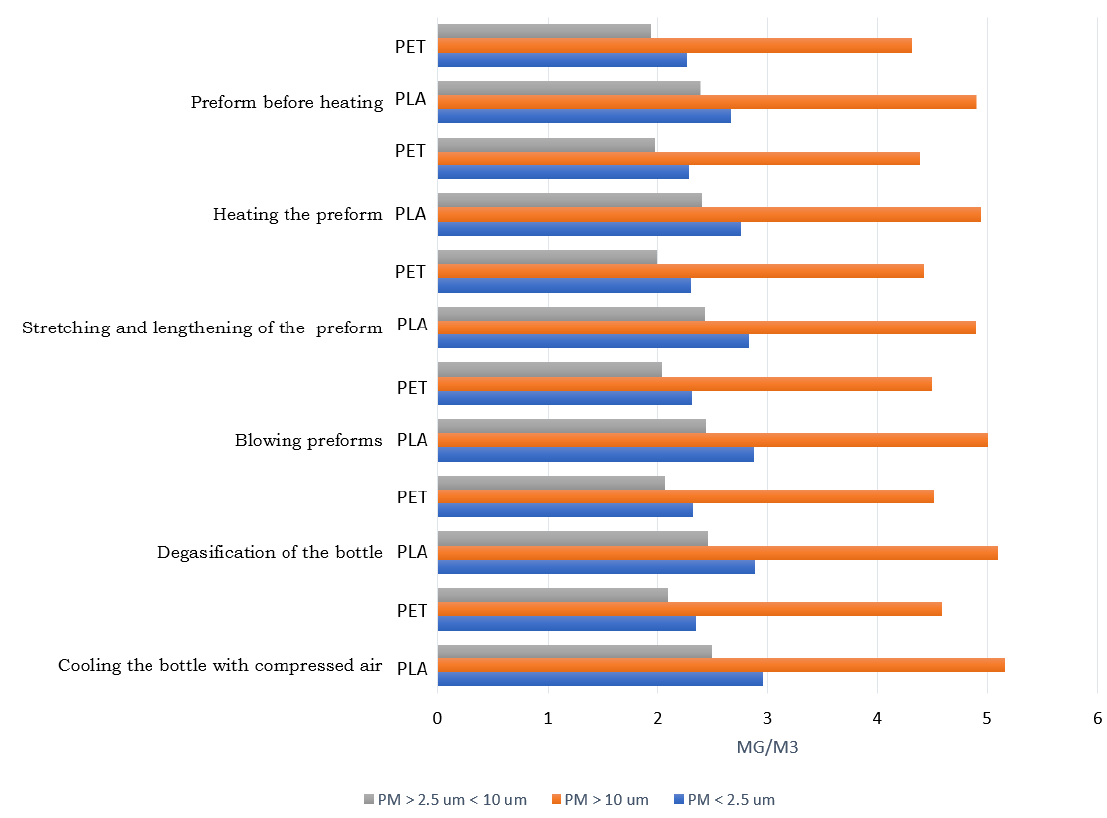
Figure 15. Dust concentrations PM < 2.5, PM > 10, 2.5 < PM < 10 in the process of shaping for PET and PLA bottles.